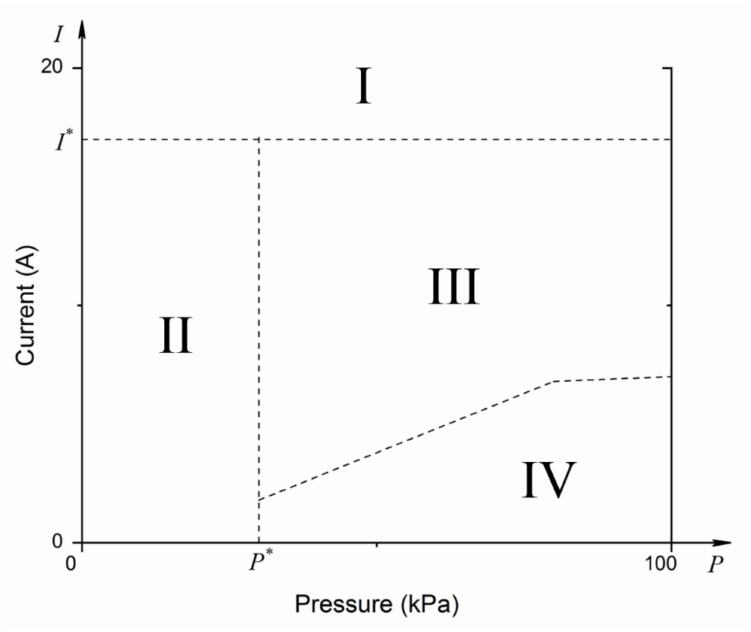
Figure 3. The four sections for energized wire at reduced